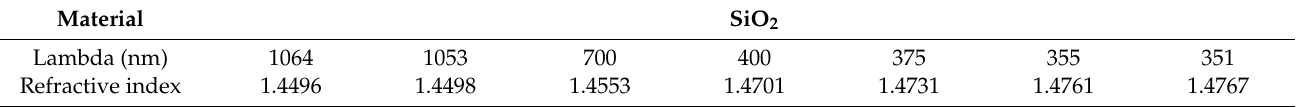
Table 2. Cont. Table 2. Membrane material index for refraction at different wavelengths.